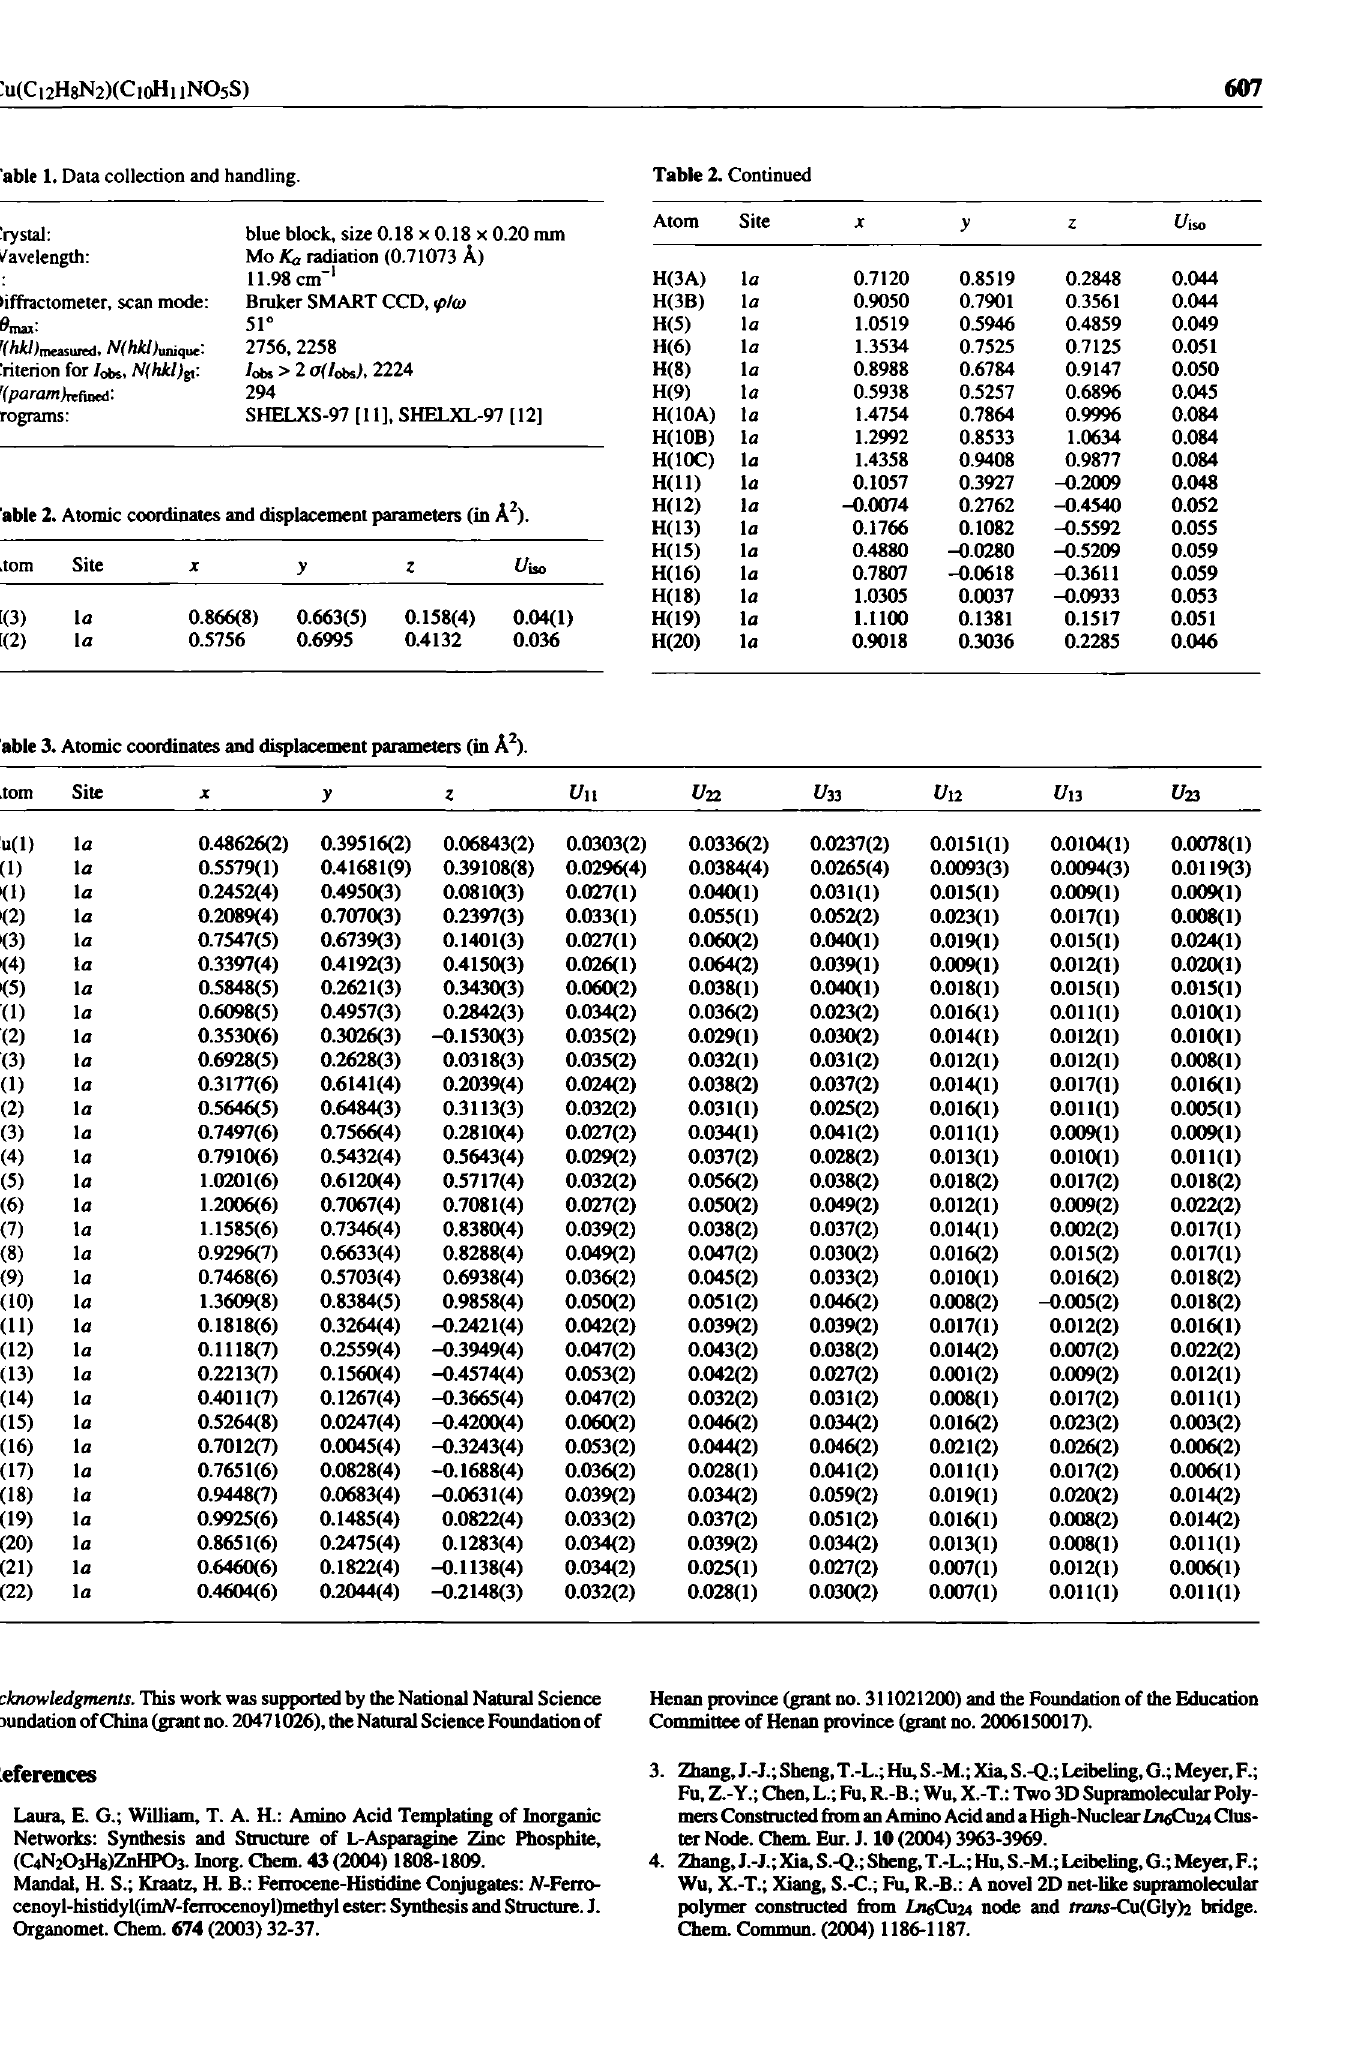
Table 3. Atomic coordinates and displacement parameters (in A 2